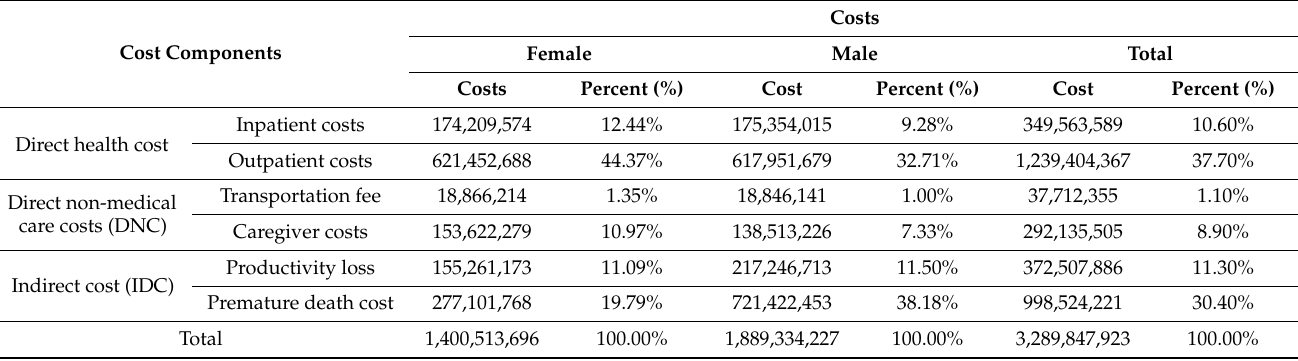
Table 3. Total estimated costs according to gender of DM (unit: KRW